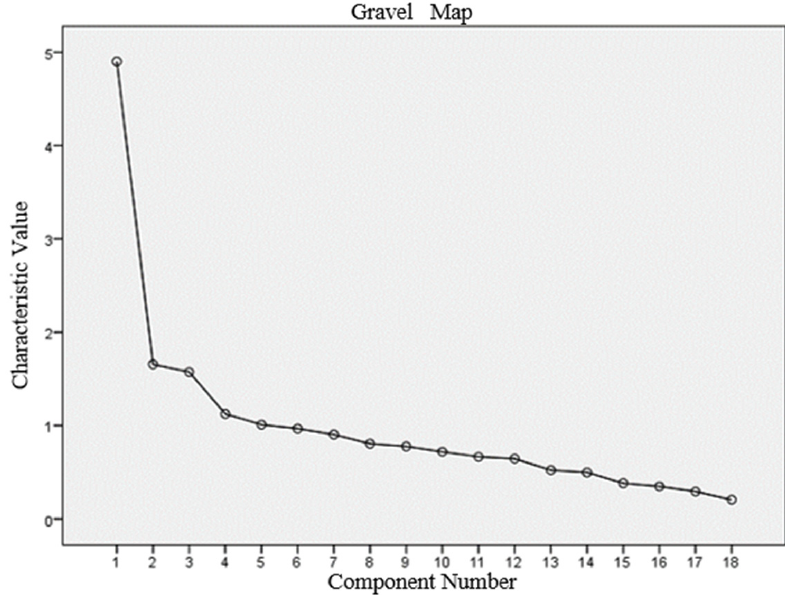
Figure 8. Gravel map of low-age corruptors’ behavior characteristics.